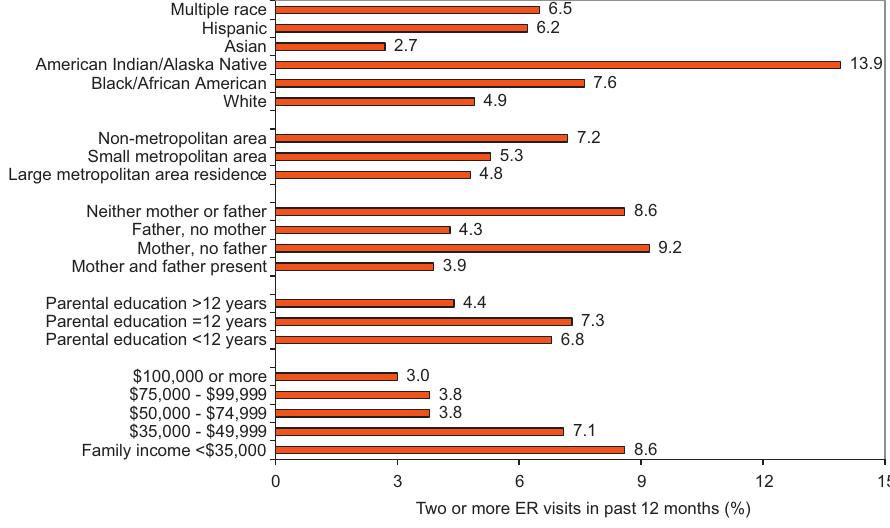
Figure 28. Emergency Room (ER) Visits by Sociodemograph ic Factors, Children <18 Years of Age, United States, 2015 National Health Interview